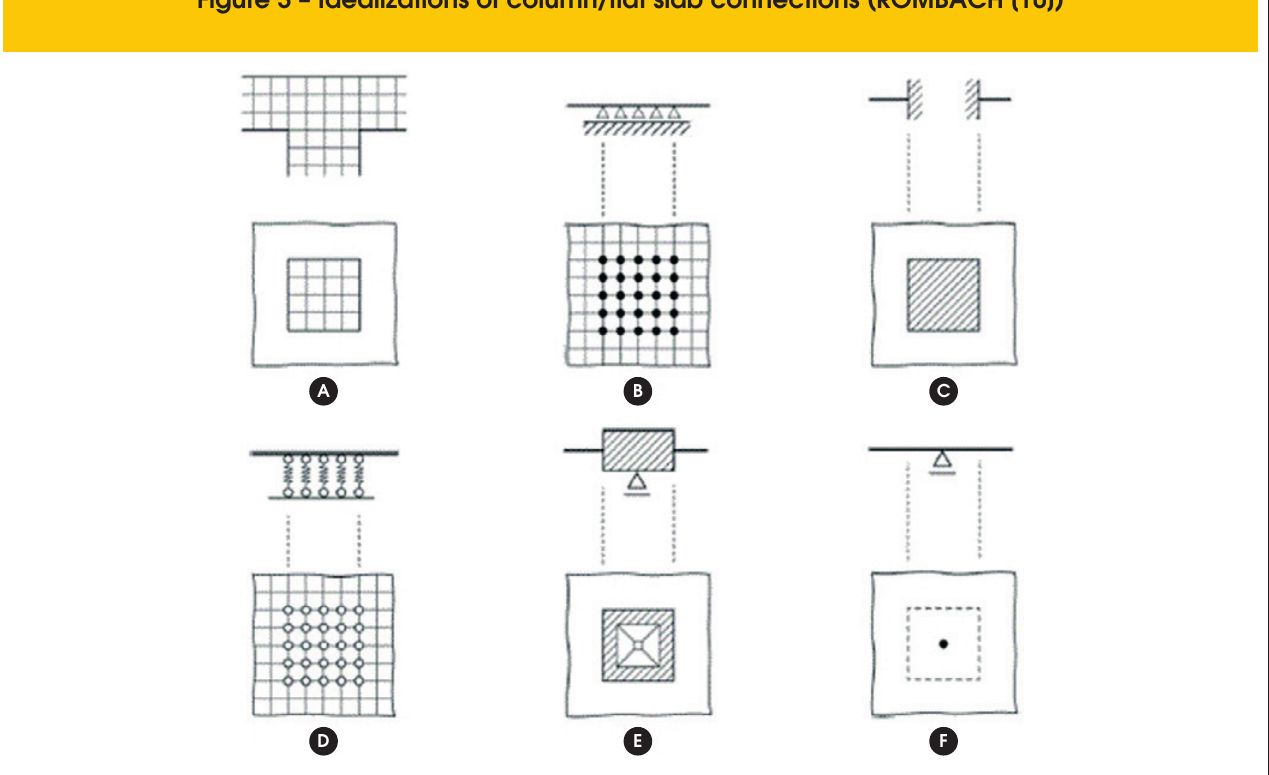
Figure 3 – Idealizations of column/flat slab connections (ROMBACH